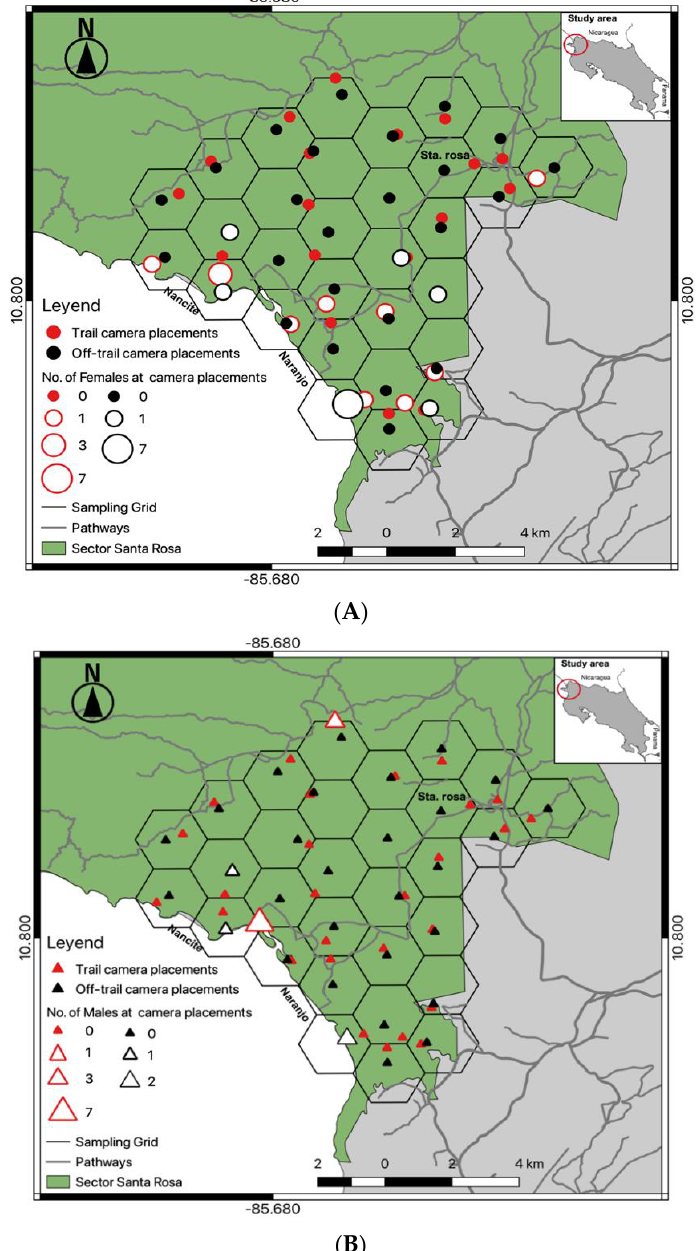
Figure 1. Camera trap deployment array at trail ( n = 29) and off-trail ( n = 29) locations in Sector Santa Rosa, Guanacaste Conservation Area, Northwestern Costa Rica; ( A ) Spatial detections of different female ( ) jaguars at camera locations; ( B ) Spatial detections of different male ( ♀